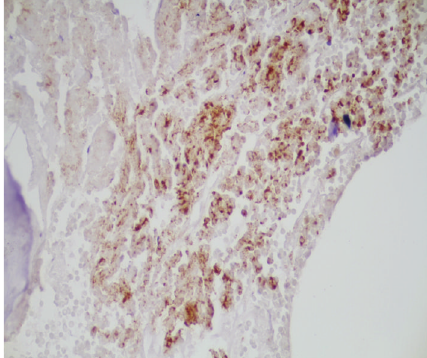
Figure 5: Chromogranin positive neoplastic cells in the bone marrow suggestive of small cell lung cancer.